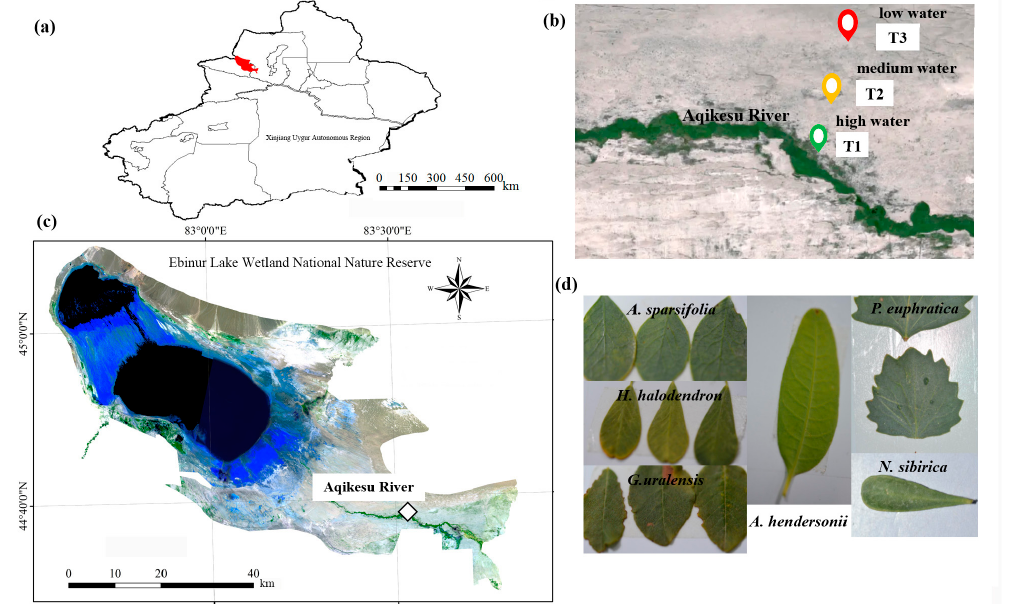
Figure 1. The study area and plots. ( a ) Location map of the Xinjiang Uygur Autonomous Region. Where the red area represents Ebinur Lake; ( b , c ) location of the study area; ( d ) leaves of A. sparsifolia , G. uralensis , H. halodendron , A. hendersonii , P. euphratica , and N. sibirica